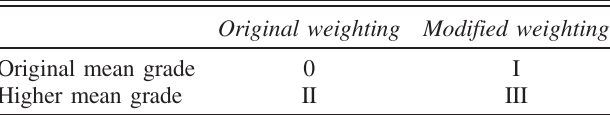
TABLE V. The four grading models.